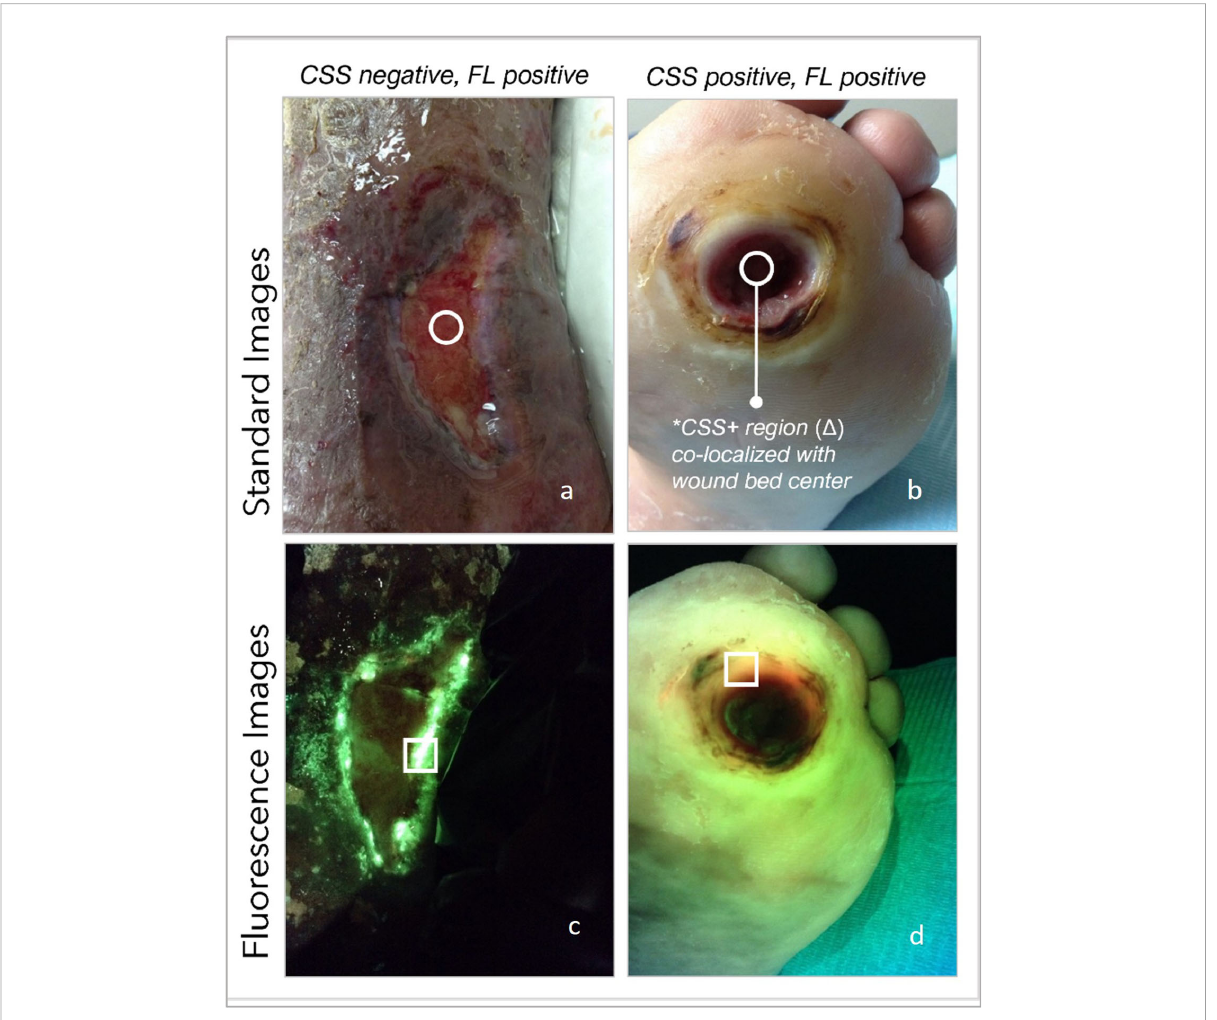
FIGURE 3 (A) Standard image of a wound deemed clinically unremarkable by the examining clinician, circle denotes location of SoC biopsy. (B) same wound under FL-imaging denotes areas positive for pseudomonas on edges of wound, far from SoC; (C) clinically remarkable plantar ulcer as per clinician ’ s assessment, on standard image; (D) same plantar wound denotes red FL-positive areas toward the edge of the wound, away from SoC